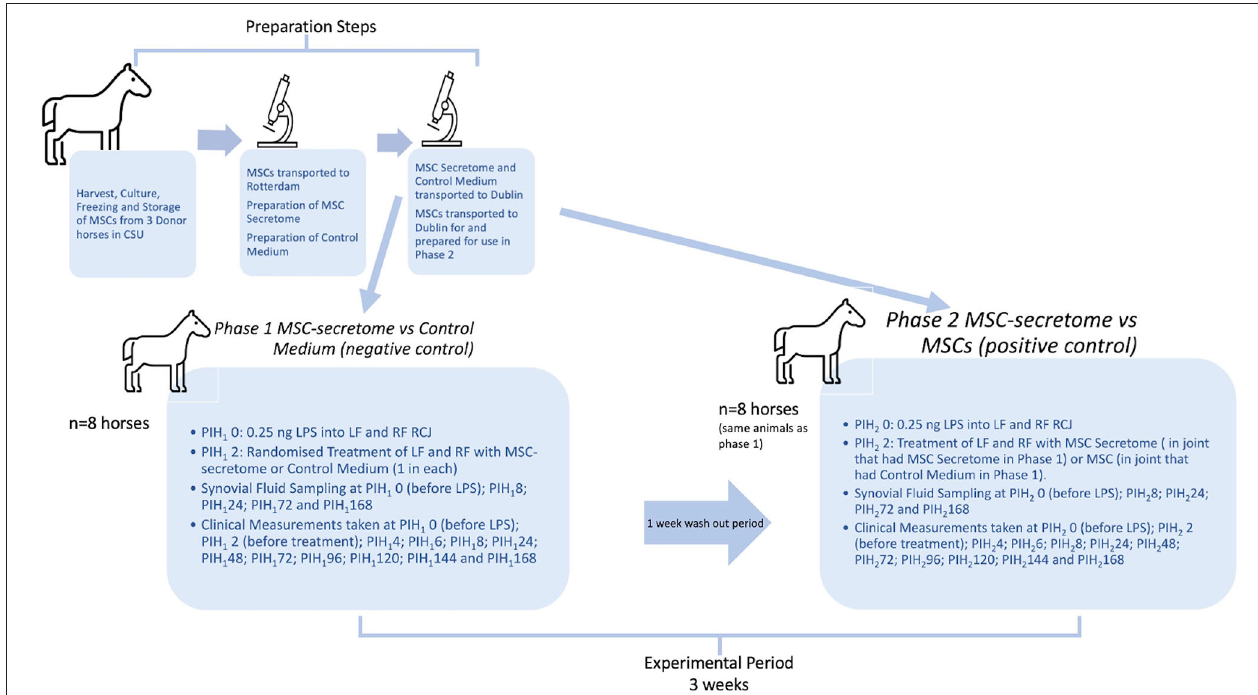
FIGURE 1 | Overview of study design. The preparation steps were carried out in advance of the experimental period. Bone marrow derived mesenchymal stem cells (MSCs) were harvested from donor horses in Colorado State University (CSU) Veterinary Teaching Hospital and cultured, frozen and stored according to their standard protocols. Later, MSCs were transported, still frozen, to Erasmus MC in Rotterdam, where they were thawed and cultured and then used to prepare Mesenchymal stem cell secretome (MSC-secretome) treatments. Cells from the same cell lines as used for the MSC preparation were also transported to Dublin, where the final preparatory steps and viability assessment were performed immediately prior to their use in Phase 2 of the experiment. The experimental period represents 3 weeks in total. PIH (Post Induction Hour) indicates time in hours after induction of inflammation with intra-articular injection of 0.25 ng of lipopolysaccharide (LPS) in each radiocarpal joint (RCJ) of 8 horses. At PIH 1 2, one randomly selected RCJ of each horse was injected with intra-articular mesenchymal stem cell secretome and the contralateral joint was injected with medium (negative control). Following PIH 1 168, horses had a washout period (7 days) during which they were on pasture rest. At PIH 2 2, the RCJ that had previously been treated with intra-articular mesenchymal stem cell secretome was again treated with intra-articular mesenchymal stem cell secretome and the contralateral joint was injected with mesenchymal stem cells (positive